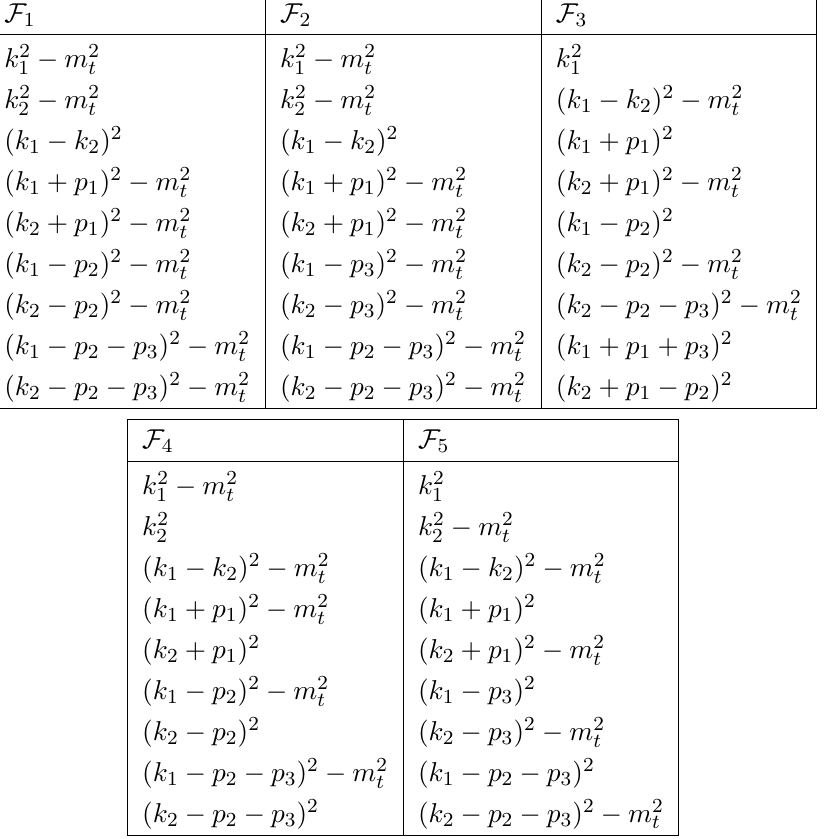
Table 1 . Planar integral families used for the reduction.